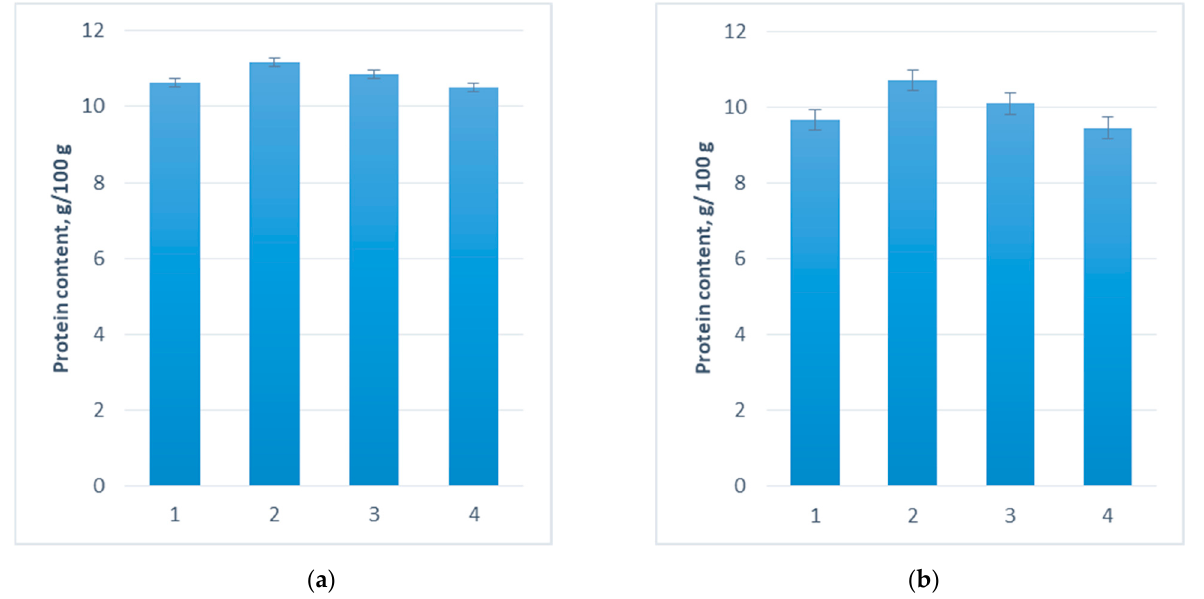
Figure 4. Effect of NaturGel and ProbioHumus on the protein content of wheat ( a ) and oat ( b ) grains. 1—Control; 2—ProbioHumus; 3—NaturGel; 4—ProbioHumus + NaturGel. Table 6. Effect of probiotics on micronutrient content of wheat and oat